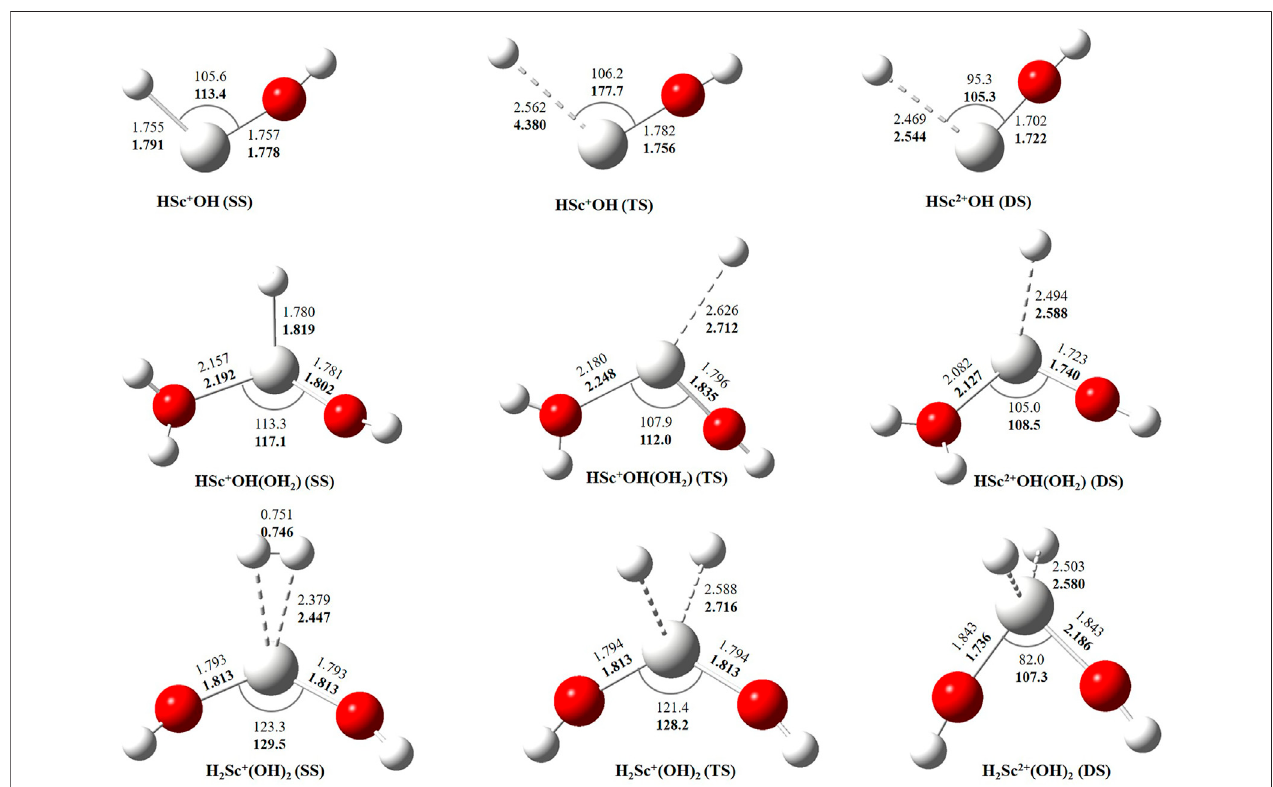
FIGURE3| Geometricalparametersofsinglet-state(SS),doublet-state(DS),andtriplet-state(TS)geometriesofHSc +/2+ OH,HSc +/2+ OH(OH 2 ),andH 2 Sc +/2+ (OH) 2 complexes obtained at B3LYP (normal) and MP2 (bold) using the 6-31G* basis set. Bond distances and angles are given in angstrom and degree, respectively.